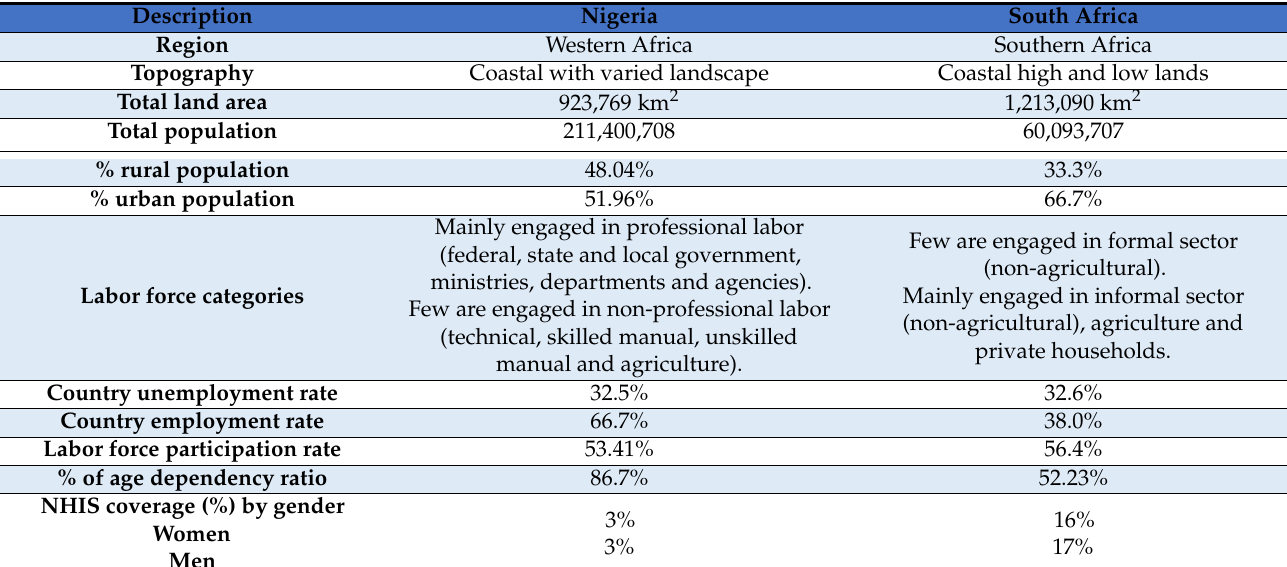
Table 1. Geographical and socio-economic comparison of study